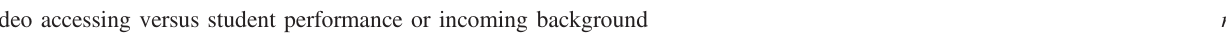
TABLE V. Relation between video accessing versus student performance or incoming background. The Pearson Correlation Coefficient ( r ) for each case is provided. Overall, students ’ video accesses do not show strong correlation to their course performance or incoming